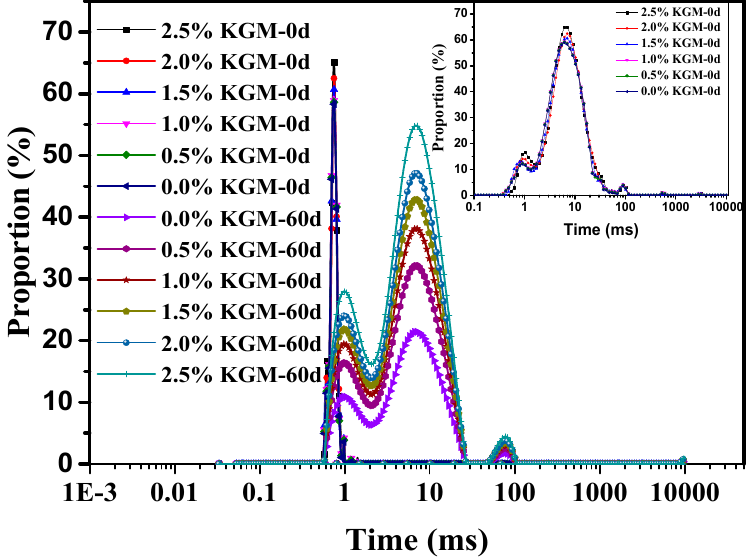
Figure 4. T 2 distribution curve of dough with different proportions of KGM added during frozen Figure4. T 2 distributioncurveofdoughwithdi ff storage.